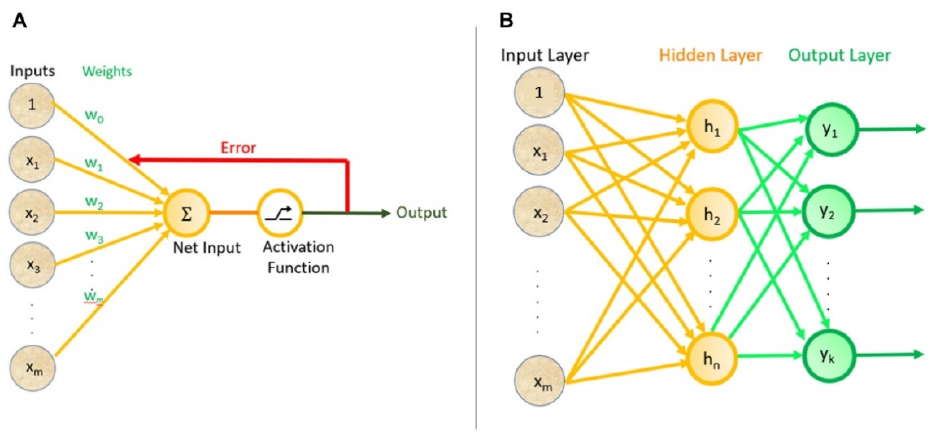
Figure 1. Neural networks. ( A ) The architecture of a perceptron. ( B ) A multi-layer perceptron.